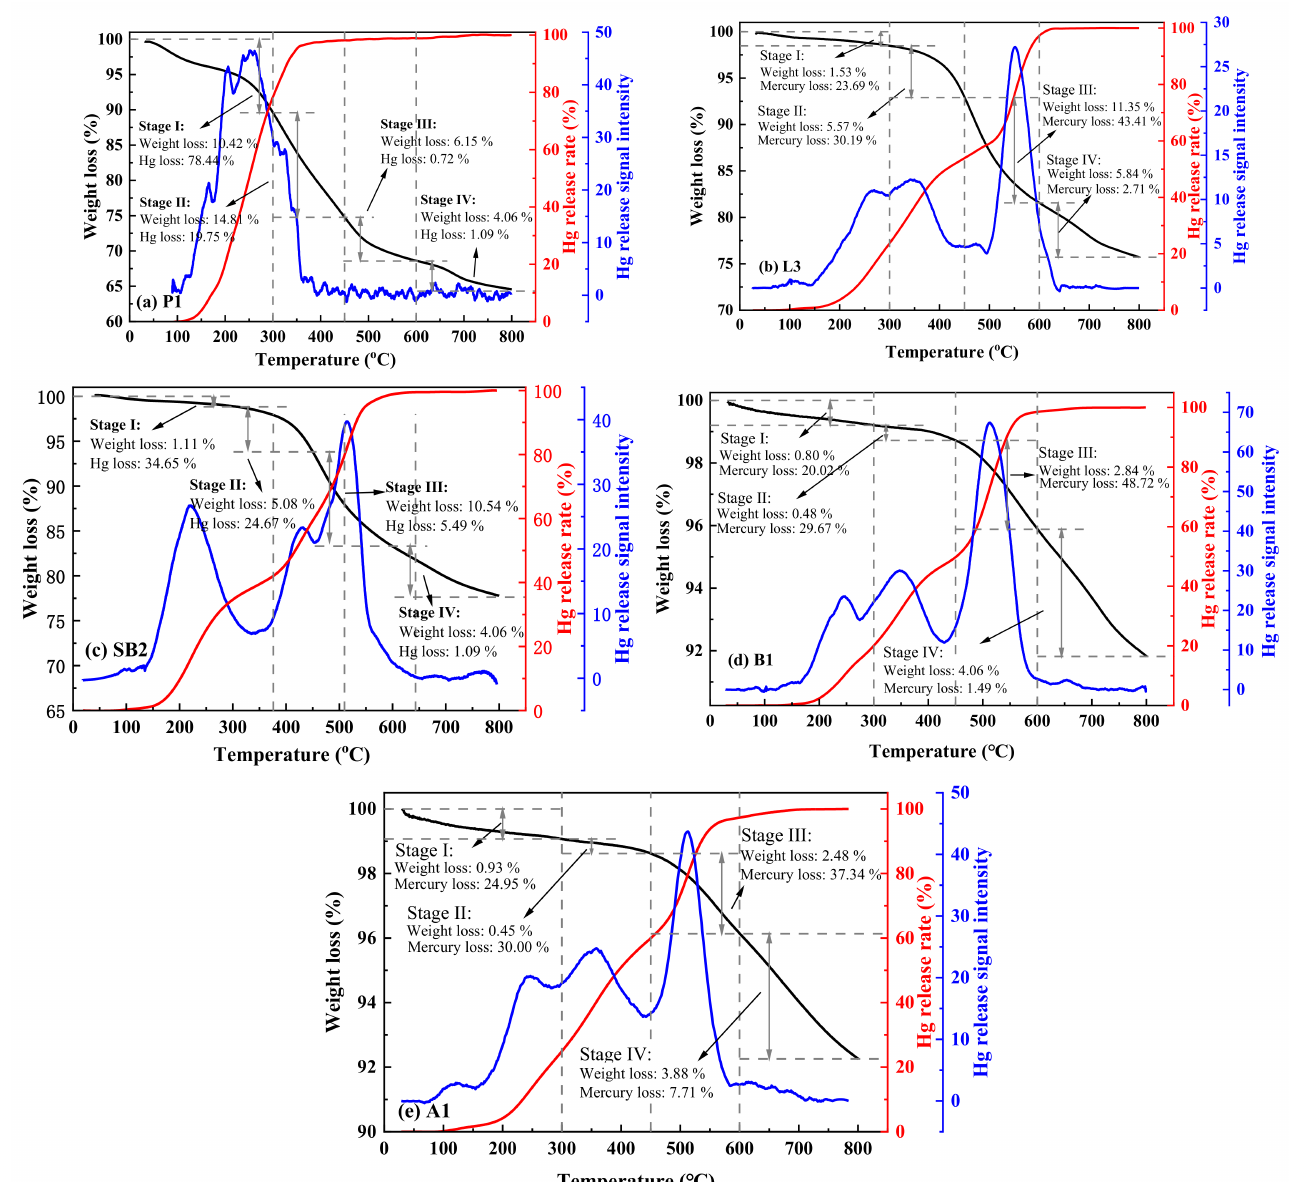
Figure 9. The relation of weight loss and the released loss of Hg in different samples. ( a ) P1 (peat); ( b ) L3 (lignite); ( c ) SB2 (sub-bituminous coal); ( d ) B1 (bituminous coal); ( e ) A1